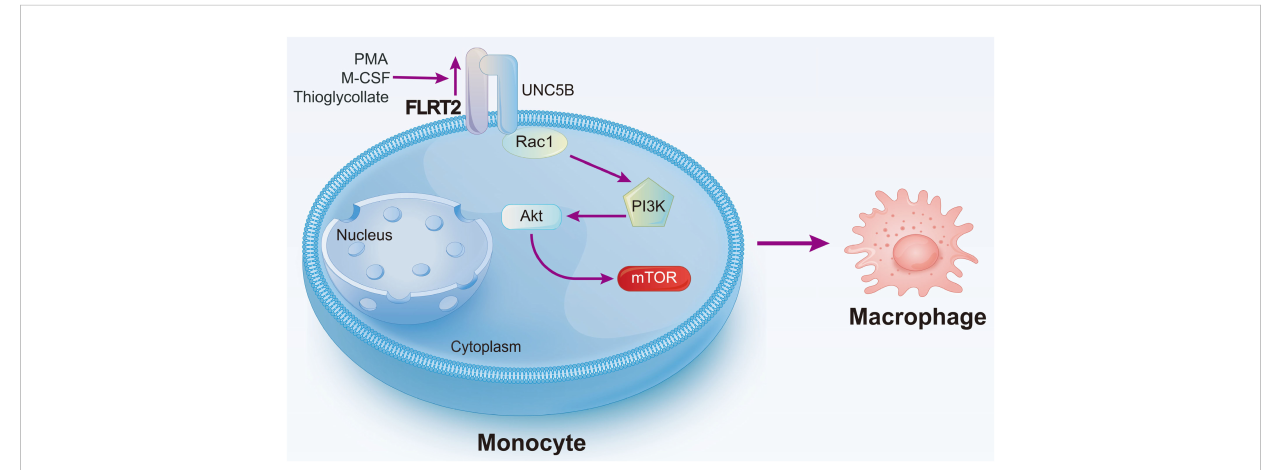
FIGURE 8 Schematic diagram of our major fi ndings. Pro-differentiation factors, such as PMA, M-CSF, and thioglycollate, upregulate Flrt2 expression in monocytes. FLRT2, in turn, accelerates monocyte-to-macrophage differentiation by binding to UNC5B via its ECD and subsequently activating the Akt/mTOR signaling